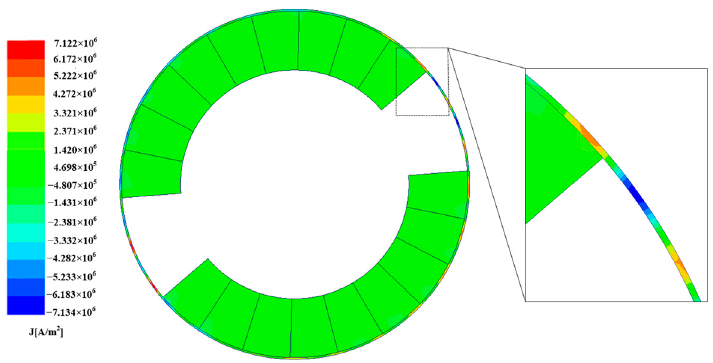
Figure 11. The eddy current density distribution of the permanent magnet and the 0.5 mm jacket.